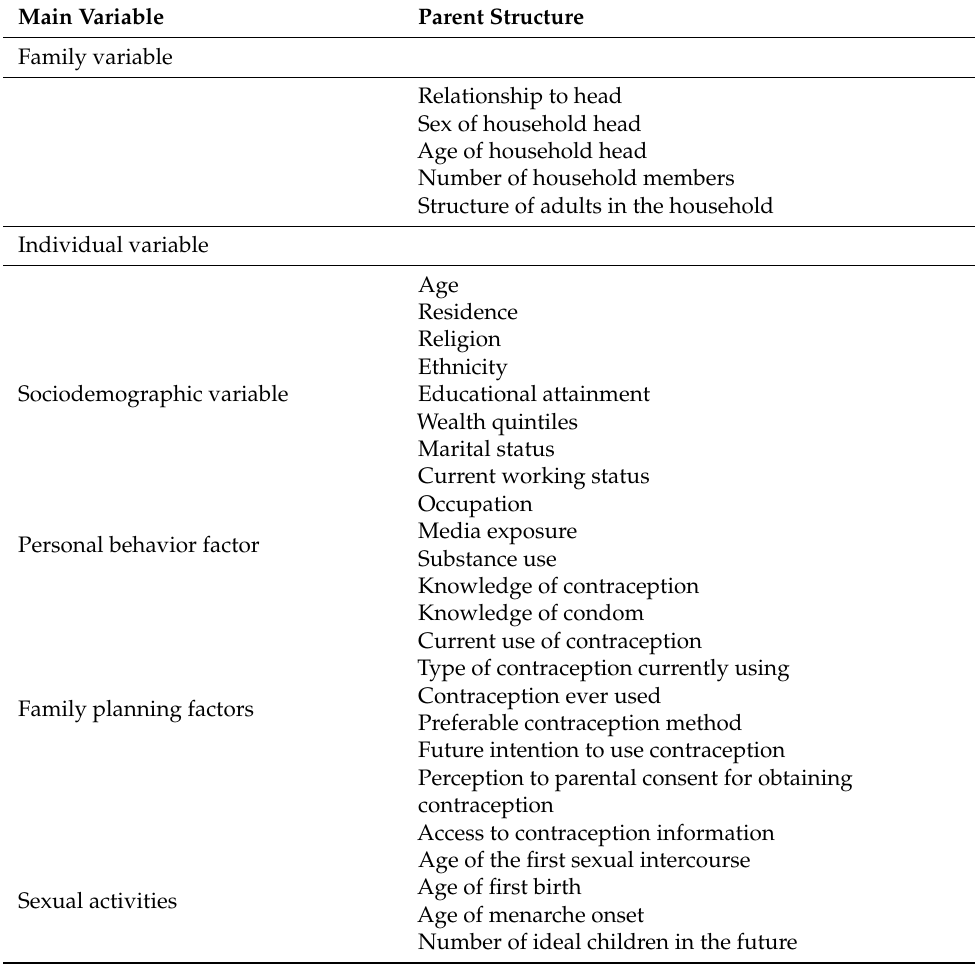
Table 1. List of exposure